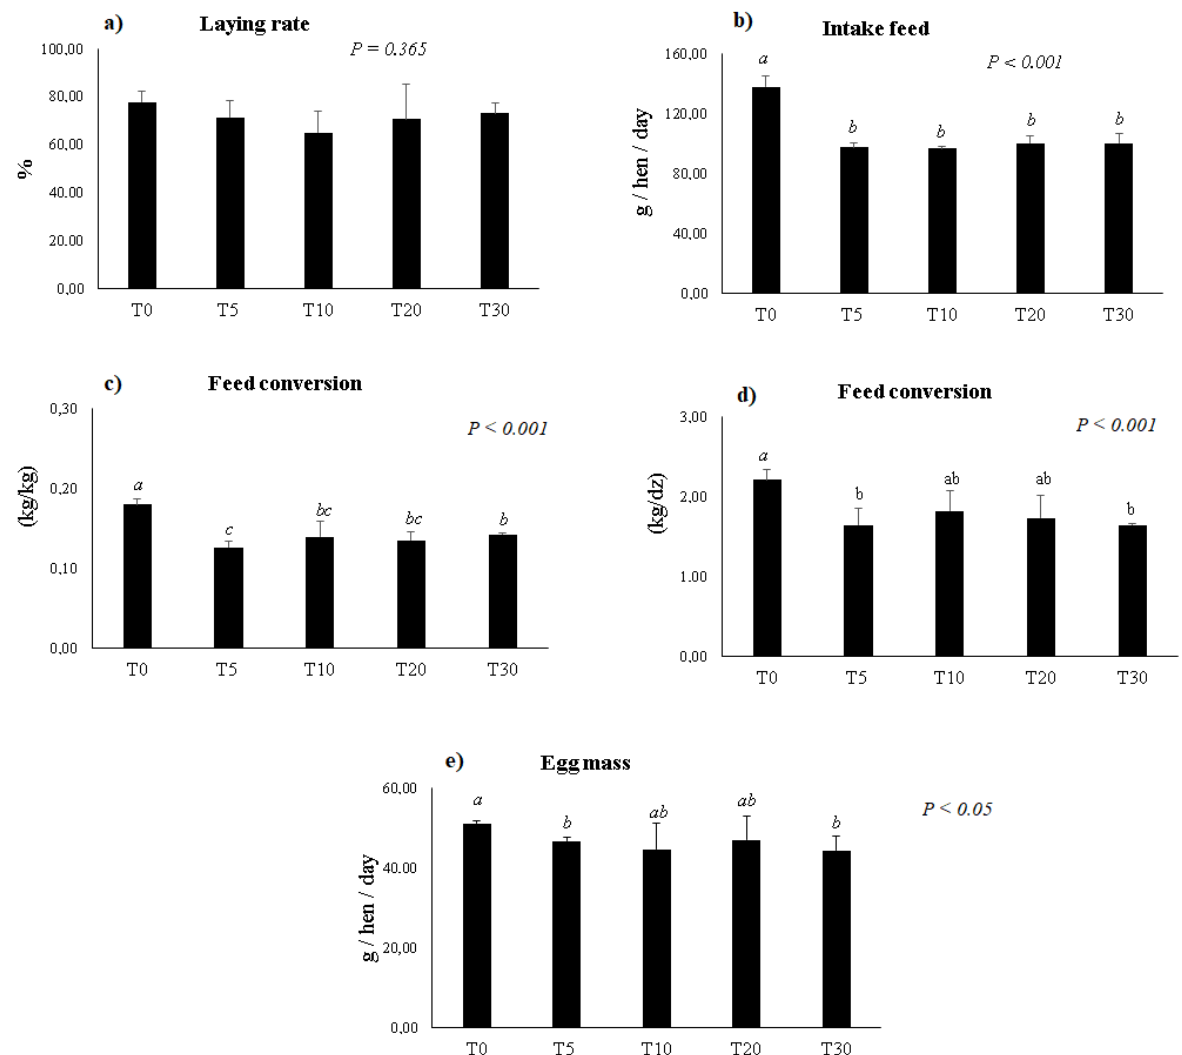
Figure 1. Productive brown Hy-line performance laying hens, 100 weeks old supplemented with increasing propolis levels: laying rate (a), intake feed (b), feed conversion - kg/kg (c), feed conversation - kg/dz (d), and eggs mass (e). * P< 0.05 and different letters (a, b and c) on the same line show a significant difference between groups. Group T0 birds that received a diet without propolis; group T5 birds that received 5 grams of propolis per kg of feed; T10 birds that received 10 grams of propolis per kg of feed; T20 birds that received 20 grams of propolis per kg of feed and T30 birds that received 30 grams of propolis per kg of